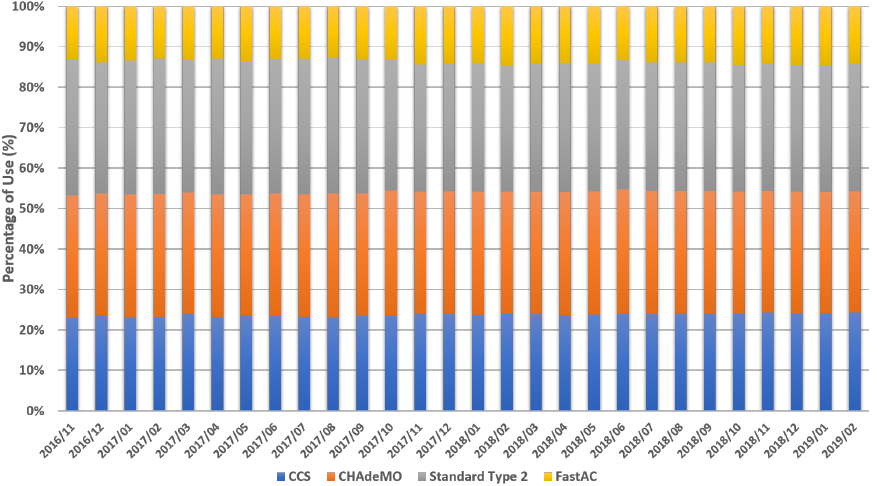
Figure 12. Monthly share of use of the the EV infrastructure, divided by type of charging station